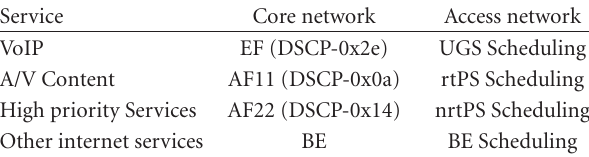
Table 4: Mapping with WiMAX tra ffi c